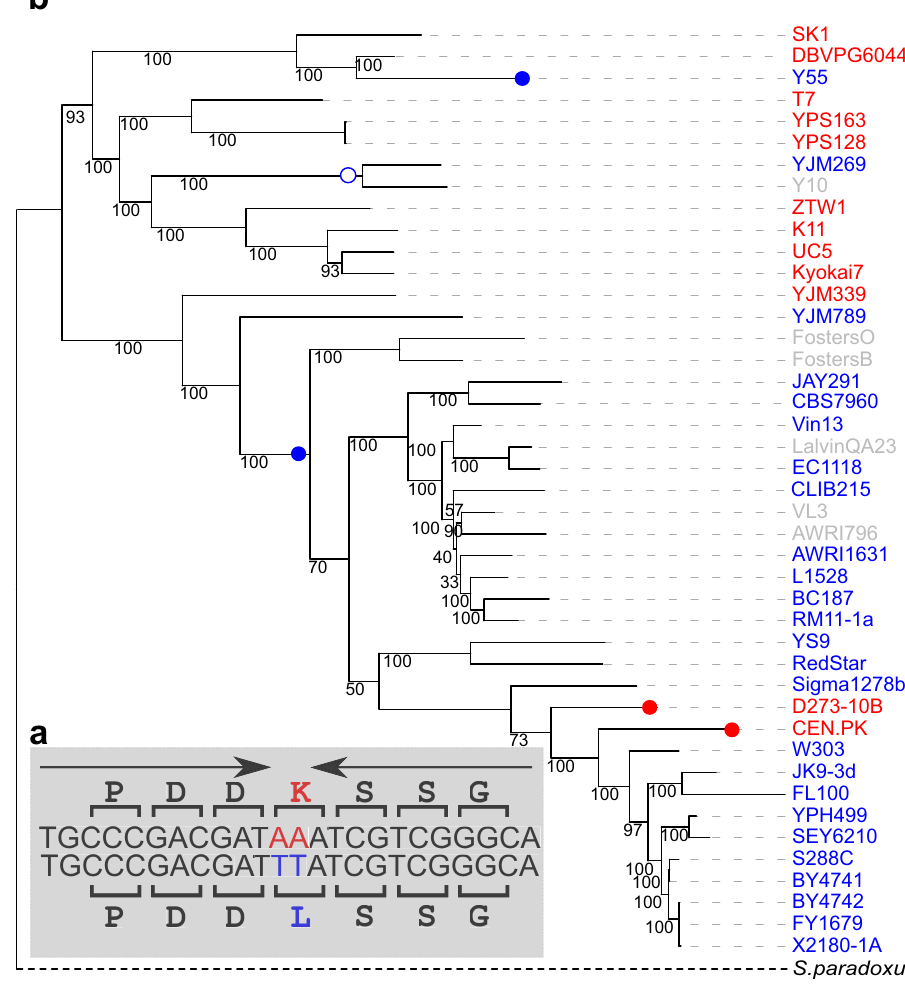
Figure 5. Spacer flip inversion in IR of SPO75 . ( a ) IR with an arm length of 11 bp shows a perfect form in all S. cerevisiae strains. The 2 bp-spacer has either the ancestral form AA (red) or the derived form TT (blue) in positions 1 and 2 of codon 409 coding AAA (K) and TTA (L) respectively. ( b ) Tree presenting the template switching events. Strains in red have AA on the spacer, strains in blue have TT on the spacer, and strains in gray have indels in this region. S. paradoxus has AA in this locus but does not share the same IR. Three transitions are shown in full circles (two from L into K, shown in red, and one from K into L, shown in blue) on terminal branches. According to ancestral sequence reconstruction, there were also one to two reversal events from K to L on internal branches, one of which has only low support (empty circle). The best maximum likelihood tree reconstructed by RAxML using DNA sequences of 4304 orthologs and the ancestral sequence reconstruction of codon 409 by FASTML, are presented (see “Methods” section). Bootstrap values are shown on branches. Tree outgroup is not drawn to